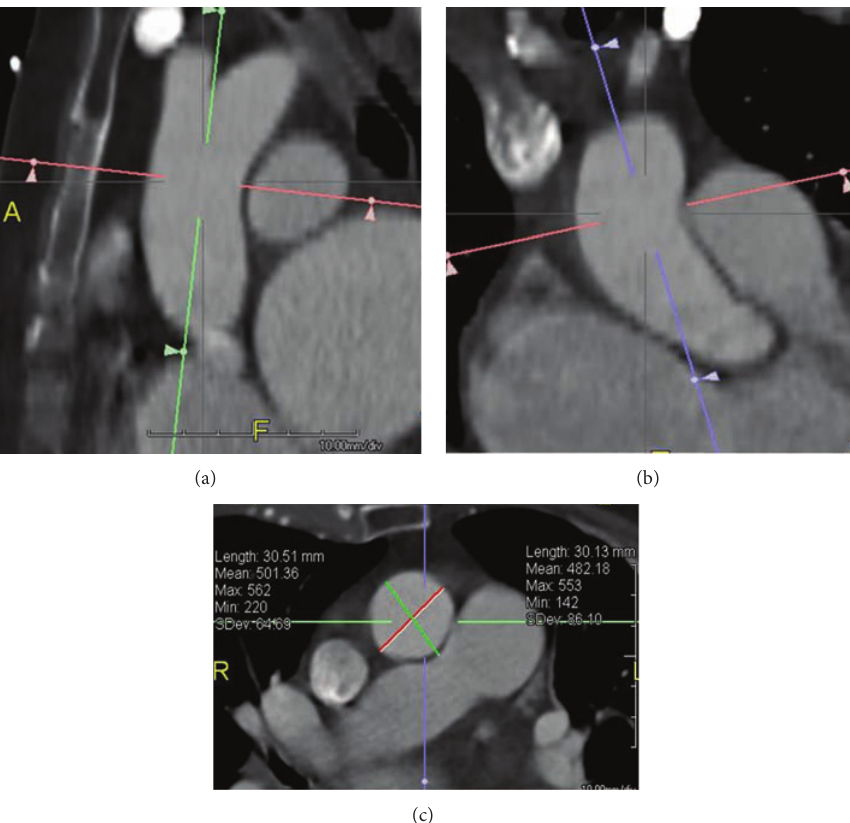
Figure 2: Measurement of aortic size by CT scan. Double oblique short axis image of mid ascending aorta (c) is acquired from orthogonal coronal (a) and sagittal (b) images at the level of mid ascending aorta. From the double oblique short axis image, minimum and maximum diameters and area are